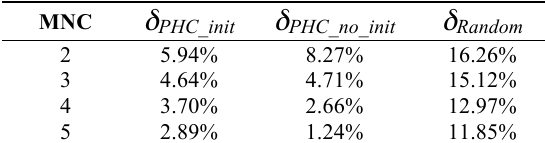
Table 3. USDEA Improvement Statistics for Cluster